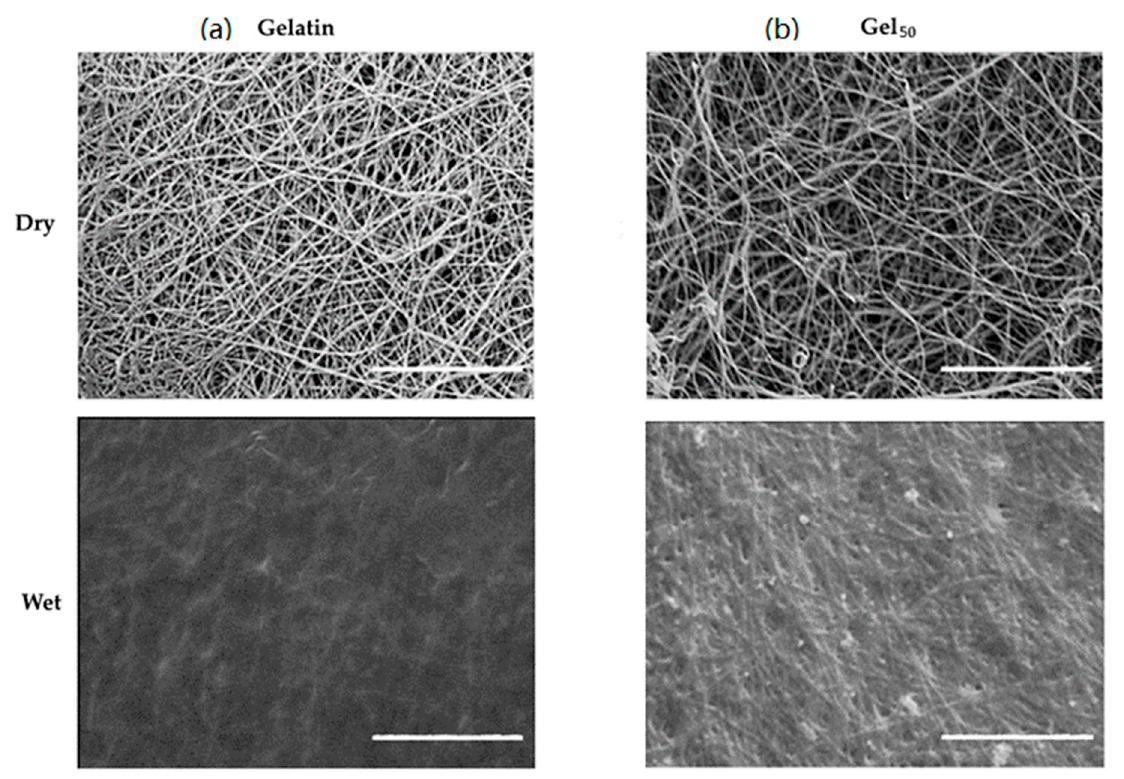
Figure 6. SEM images of electrospun gelatin NGCs at different porosity percentages: ( a ) 36%; ( b ) 50%. Scale bar: 10 µm.